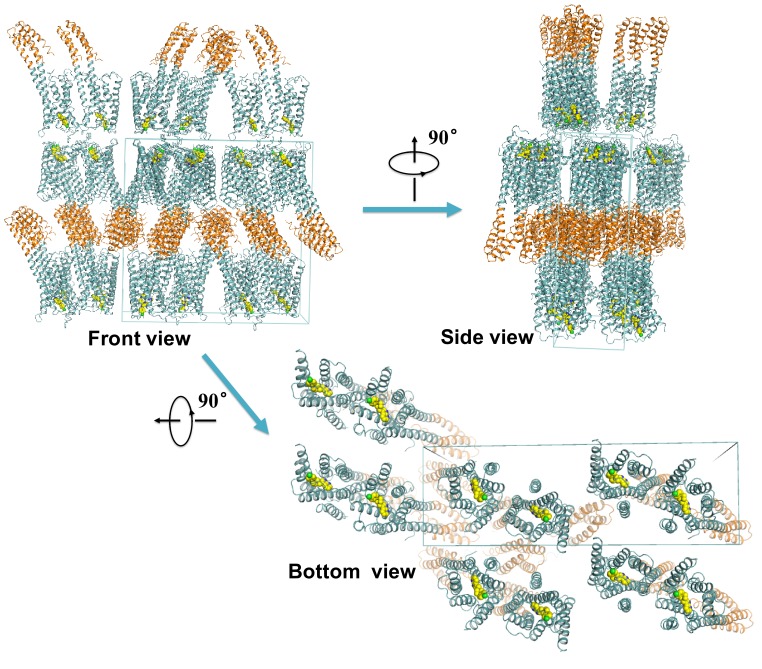
Crystal packing of the mouse DRD4.The D4 dopamine receptor is shown in aquamarine, BRIL fusion protein is shown in brown, and L745870 is shown as yellow sphere models. The blue box depicts the crystallography unit cell.